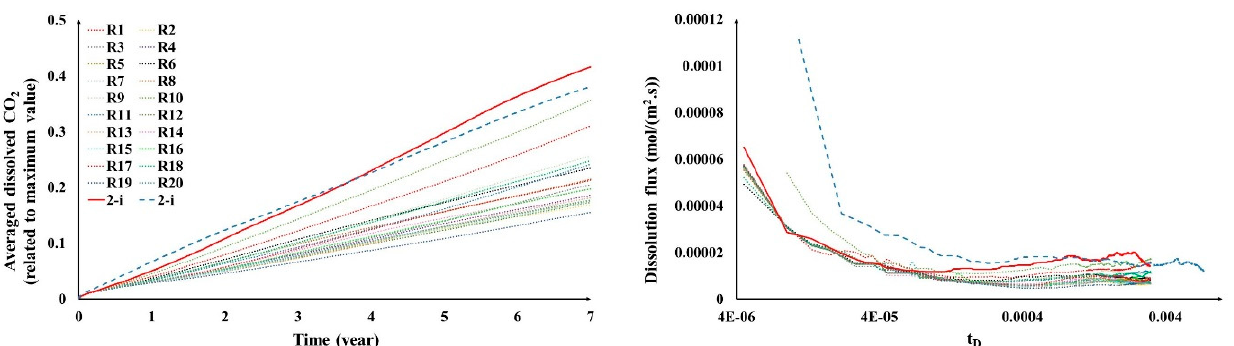
Figure 7. The heterogeneous realizations (dotted lines), homogeneous with considering cross-diffu- sion (solid line), and homogeneous without considering cross-diffusion (dashed line) averaged dis- solved CO 2 and dissolution flux for case 1-i. Legends for left- and right-hand subplots are same.